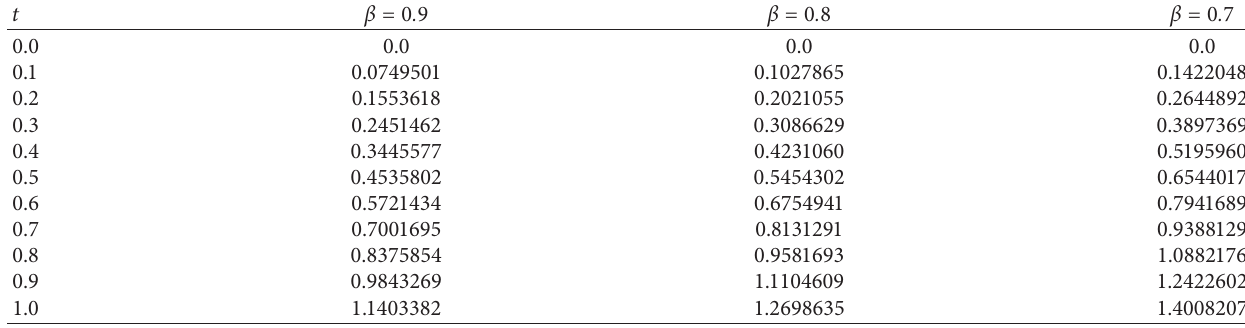
( t ) for Example 2 for different values of β , k � 6, and t ∈ [ 0 , 1 ] 1 , 6